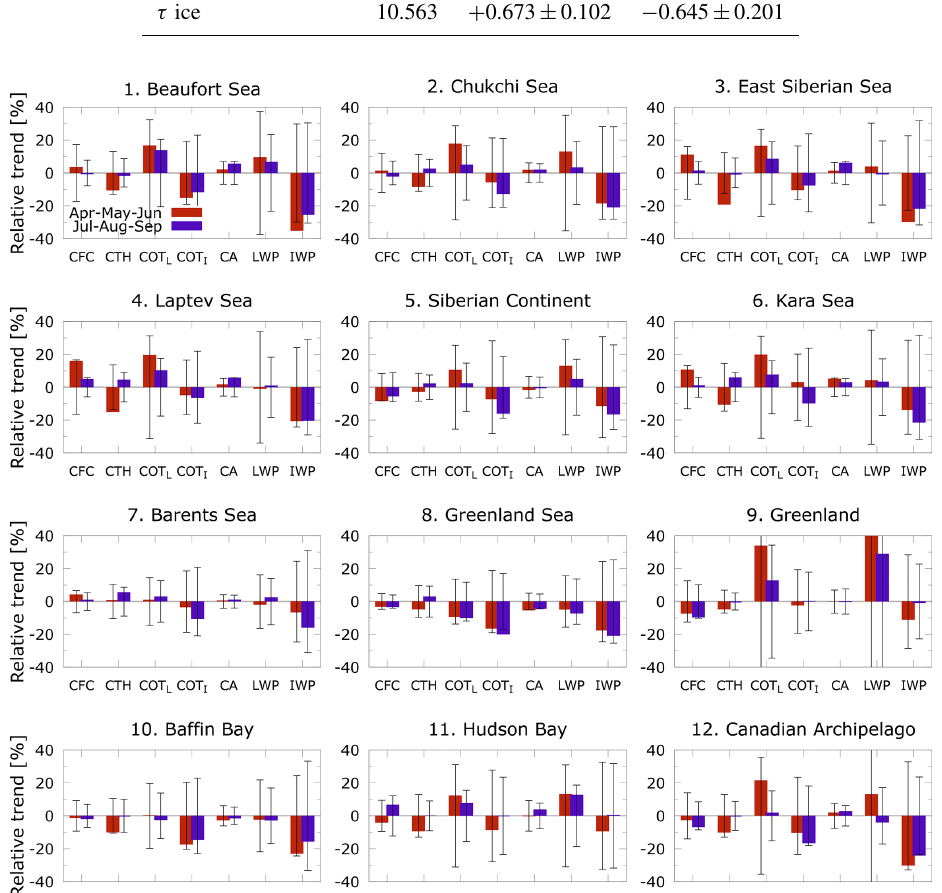
Figure 10. Trends (and 2 σ standard deviation) of cloud fractional cover (CFC), top height (CTH), the optical thickness of liquid (COT L ) and ice phase (COT I ), albedo (CA), and liquid and ice water path (LWP and IWP) for the 12 sectors defined in Fig. B1 for spring (April– May–June, red bars) and summer (July–August–September, purple) months. The y axis displays the change relative to the leading season in 1996 and expresses the total change throughout the full